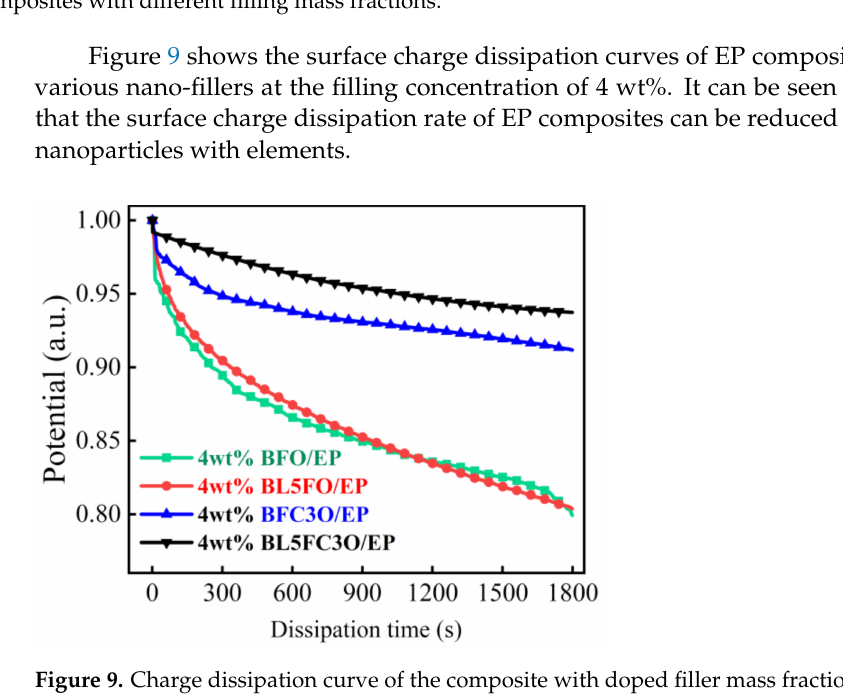
Figure 8. ( a ) Charge dissipation curves of BFO/EP composites with different filling mass fractions; ( b ) charge dissipation curves of BL5FO/EP composites with different filling mass fractions.